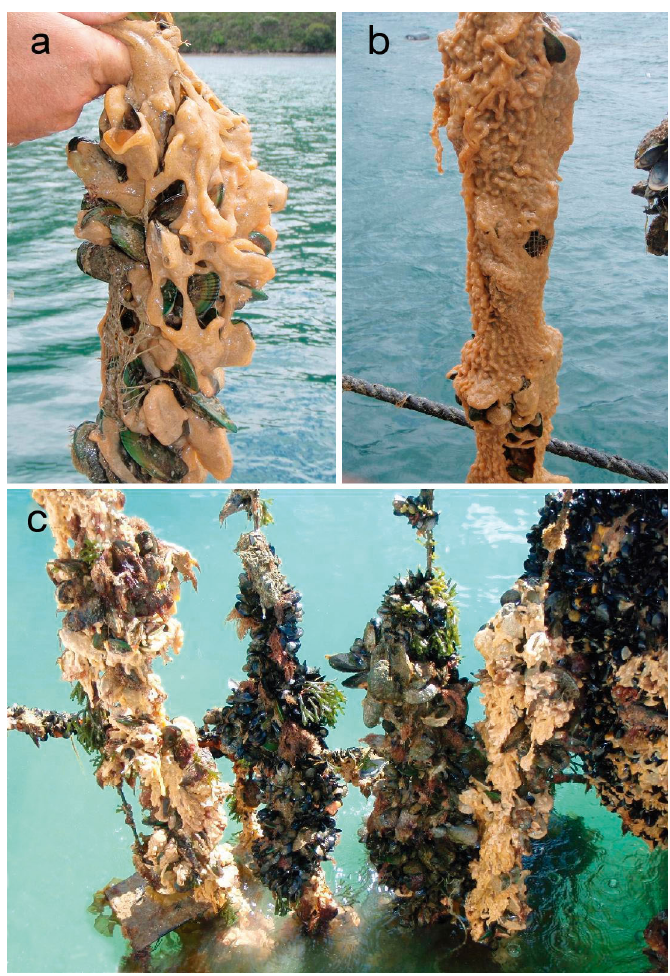
Fig. 2. Perna canaliculus and Didemnum vexillum . Set-up of experi- mental mussel lines. (a,b) Enhanced fouling treatment lines 6 wk af- ter inoculation with D. vexillum fragments on 28 November 2008. (c) Experimental lines on 29 January 2010, ~14 mo after deployment. The 2 lines in the centre are from the control group, and the lines on the far left and far right are from the enhanced fouling group, high- lighting the differences in D. vexillum biomass present between treatments. Photographs by